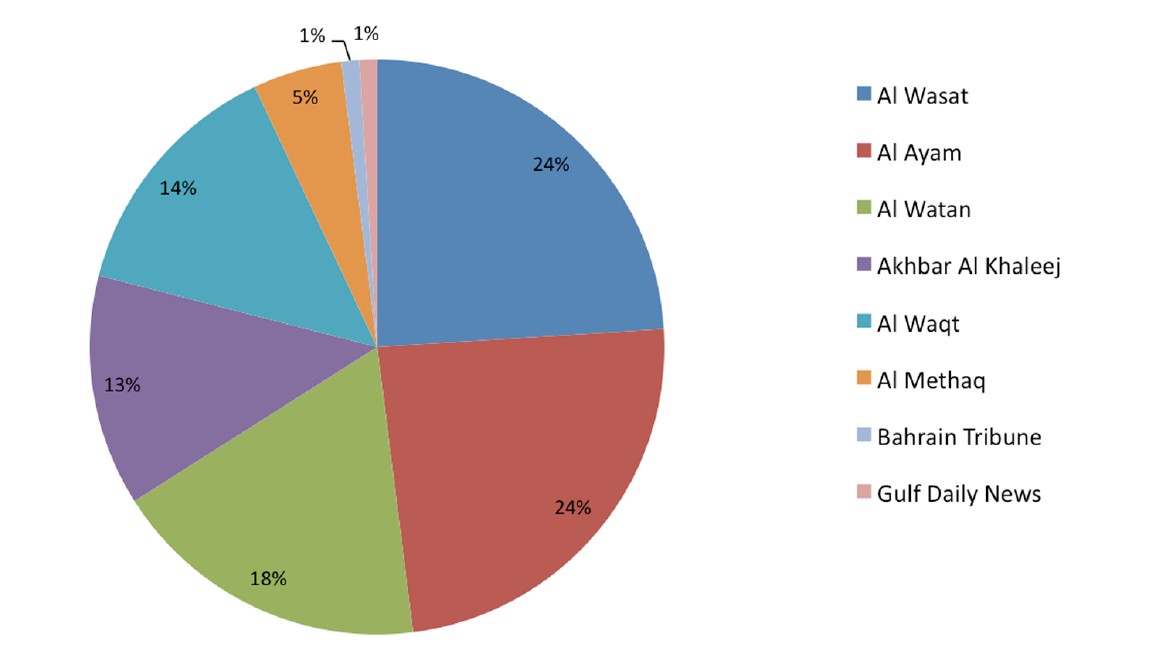
Figure 5: The space allocated to parliamentary elections in newspapers, 2006